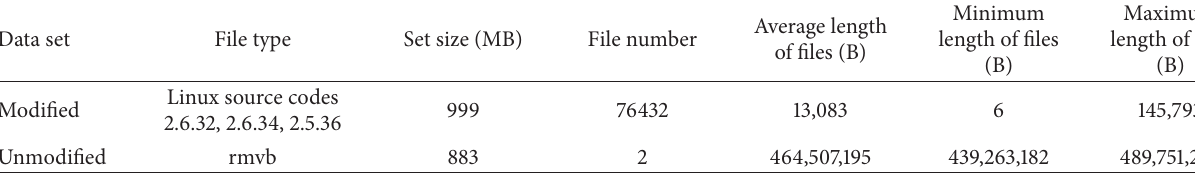
Table 1: Chunking test data set.